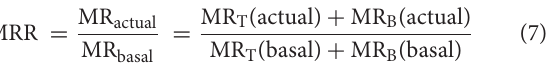
) and O 2 ( P aO ), and heart rate ( HR ). 2 2